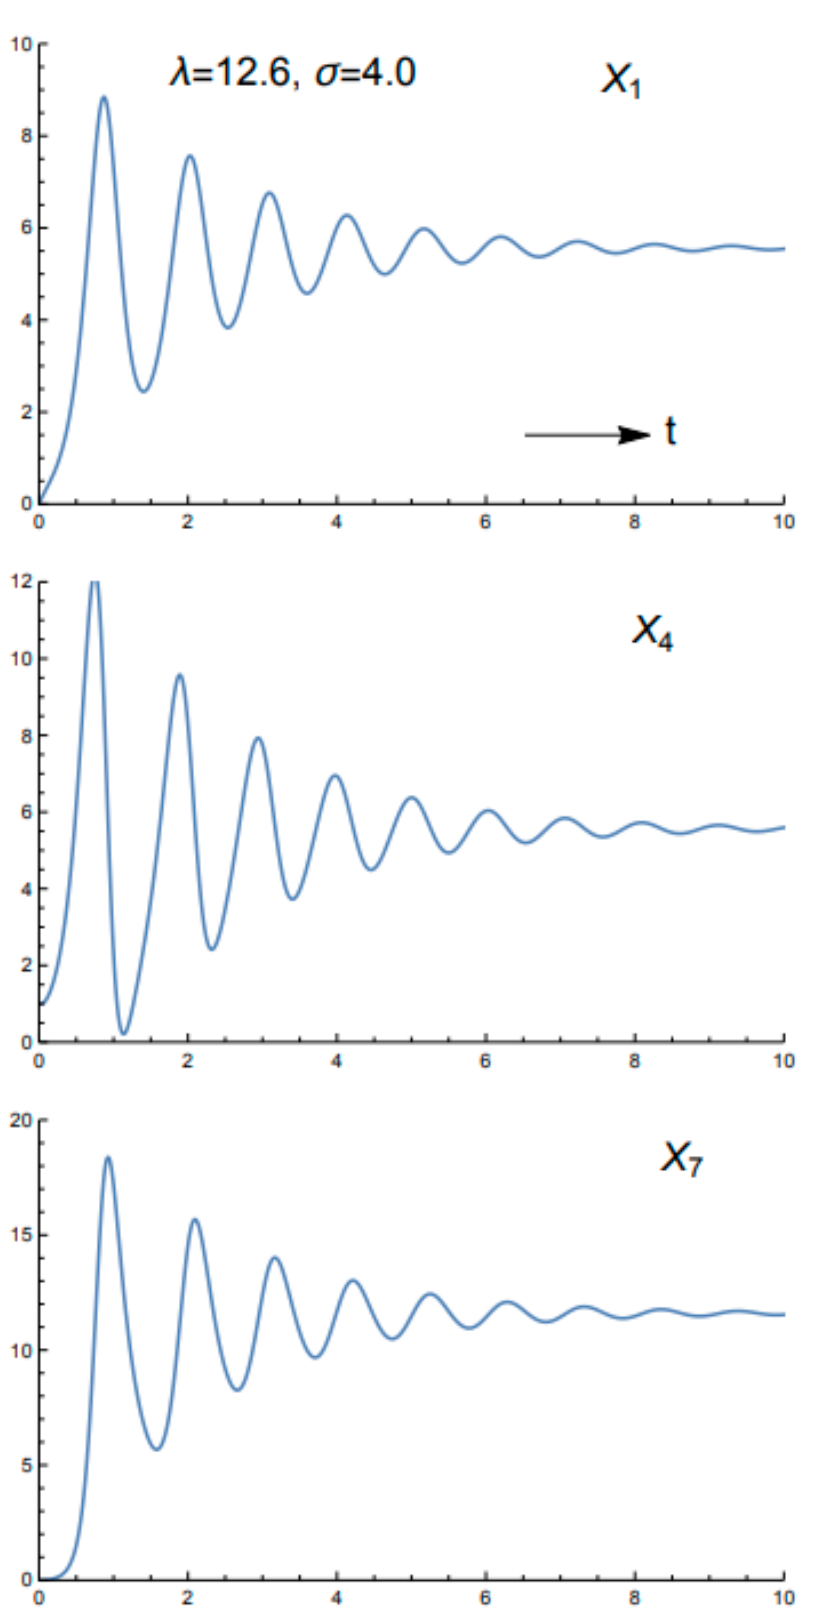
Figure 7. Forecast of the three amplitudes x 1 , x 4 , x 7 for the nonchaotic regime using L-LOM (3) over the time span [0, 10] with guess controls λ = 12.6, σ = 4.0 .